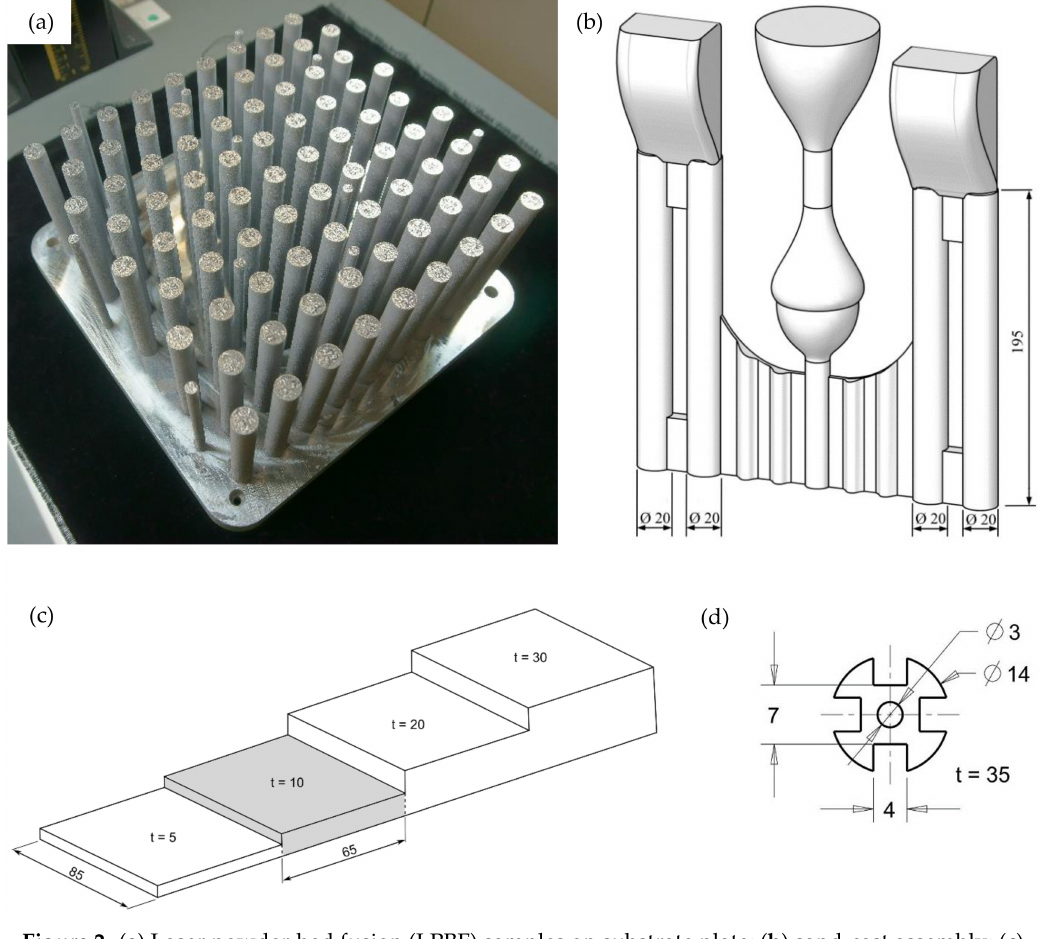
Figure 2. ( a ) Laser powder-bed fusion (LPBF) samples on substrate plate; ( b ) sand-cast assembly; ( c ) die-cast geometry; ( d ) modified sample geometry for improved quenching rates in the induction